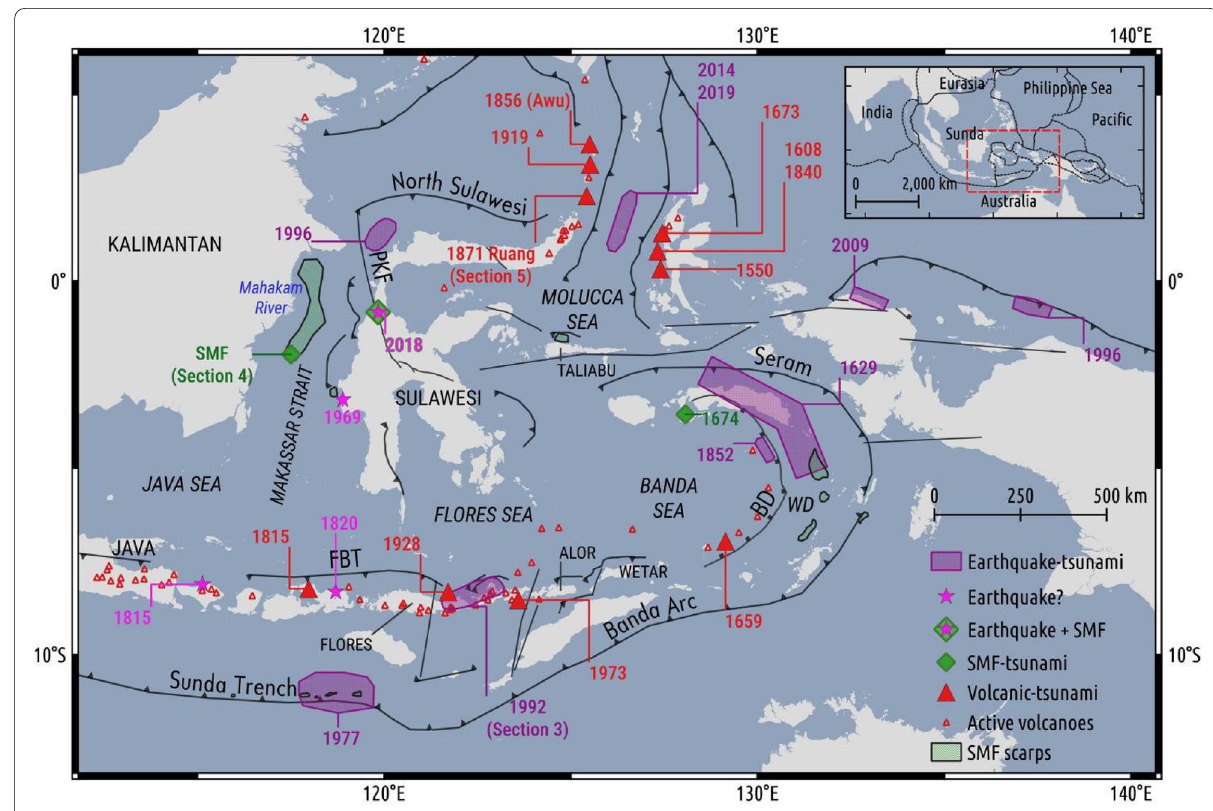
Fig. 1 Eastern Indonesia tectonic setting showing selected past major tsunamigenic events along with the type of the tsunamigenic source. Solid black lines show the tectonic plate boundaries of Bird (2003). Tsunamigenic sources are compiled from; earthquake-tsunami: Cummins et al. (2020); Gunawan et al. (2016); Gusman et al. (2009); Heidarzadeh et al. (2021); Liu and Harris (2013); Matsutomi et al. (2001); Pelinovsky et al. (1997); Pranantyo and Cummins (2019b); volcanic tsunamis are taken from Paris et al. (2013); SMF tsunami is from Pranantyo and Cummins (2019a), whereas SMF scarps are from Brune et al. (2009b, 2009a, 2010); Watkinson and Hall (2017); Pownall et al. (2016); Brackenridge et al. (2020) and Nugraha et al. (2020). FBT Flores Back-arc Thrust, BD Banda Detachment, PKF Palu-Koro Fault, WD Weber Deep, SMF Submarine Mass